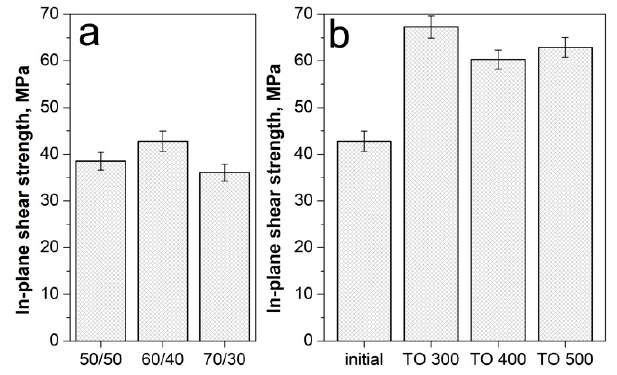
Figure 6. The in-plane shear strength of the CF/PSU composites depending on fiber content ( a ) and the fiber surface modification regime ( b ).